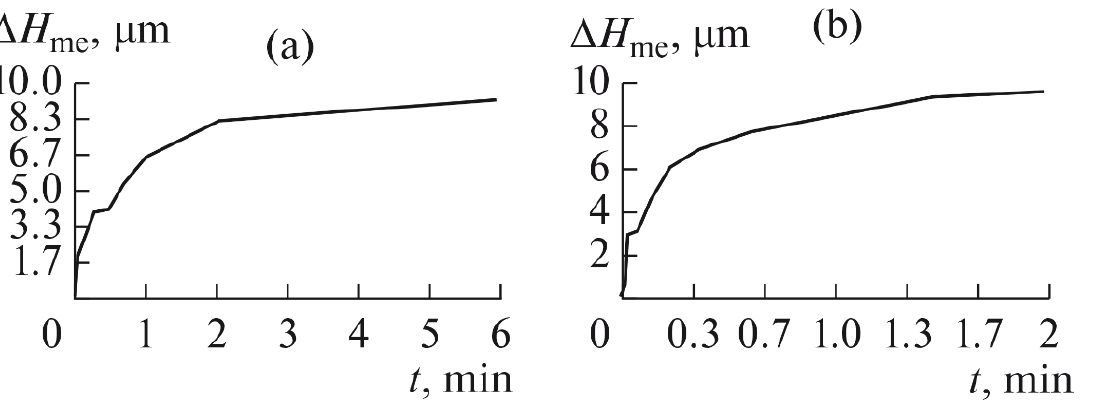
Figure 22. Linear removal ∆ H me of the material with the same constant (6.4 kg) ( a ) and variable (0–34 kg) ( b ) clamping forces.